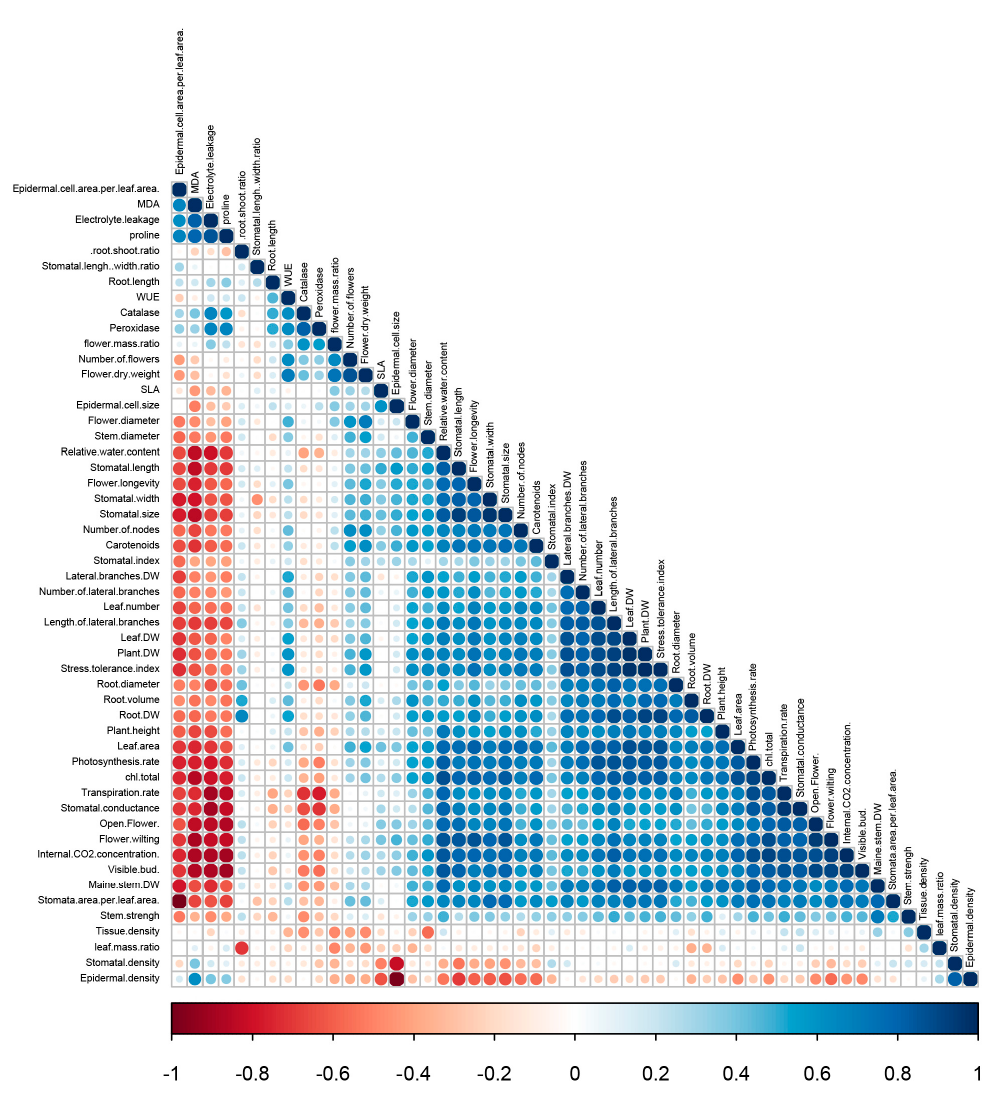
Figure 2. Positive, neutral and negative affinities across morpho-physiological traits in periwinkle cv. ‘Pacifica XP Really Red’. Plants initially received NaCl (0, 30 and 50 mM) or CaCl 2 (15 and 25 mM) via irrigation (five applications at 3 d intervals), and subsequently exposed to different watering levels (80, 50 and 20% available water content) during cultivation. At first application, plants were at the four-leaf stage. Positive correlations are indicated by blue circles, while negative associations are expressed by red circles. The intensity of color corresponds to the correlation coefficient (r) ranging from − 1 to 1 (scale). The larger size of circles indicates statistically significant values (non-significant, p = 0.05, p = 0.01 and p = 0.001,